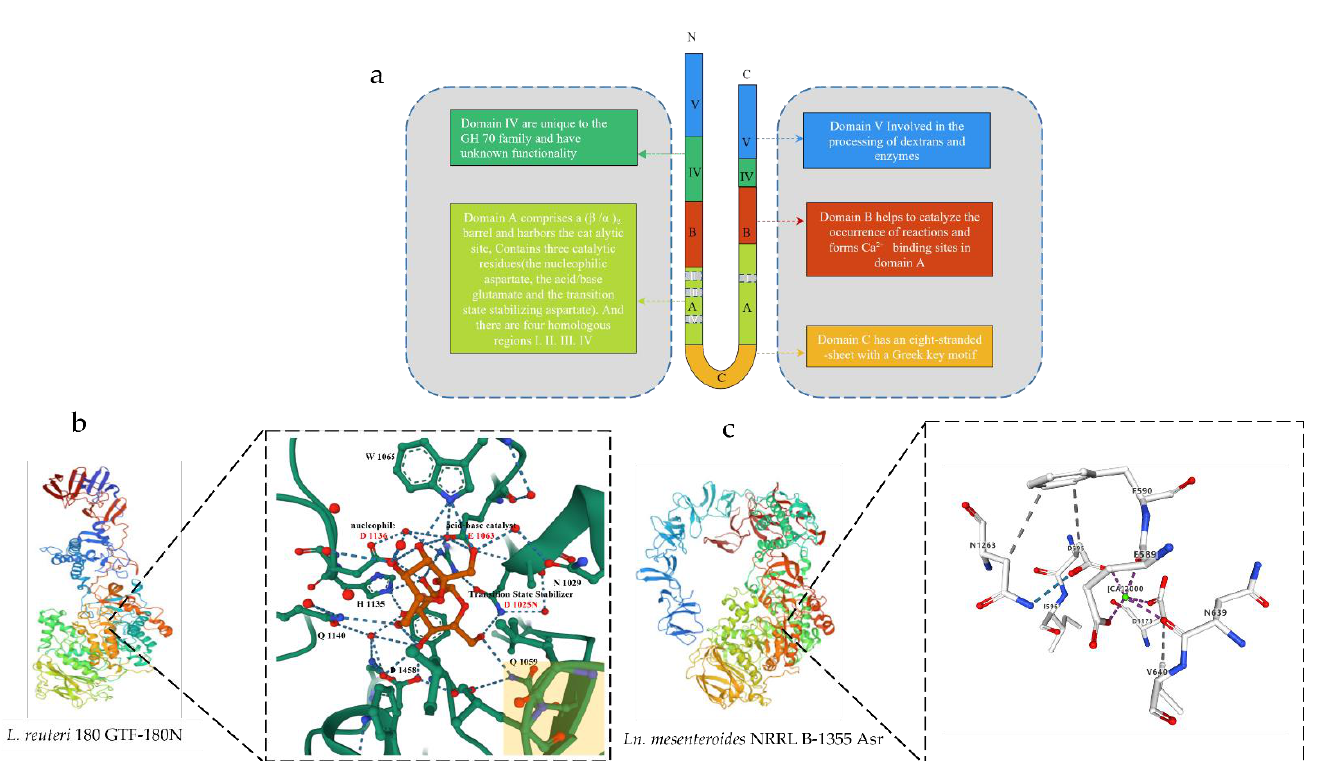
Figure 1. Schematic diagram of the 3D structure of GS. ( a ) Schematic representation of the U-shape fold formed by the various domains of GS. ( b ) Schematic diagram of the 3D structure of Ln. reuteri GTF-180N (PDB: 3HZ3) and sucrose binding site. Sucrose molecules are shown in red, residues in domain A are shown in green carbon, and residues in domain B are shown in yellow at the bottom right. ( c ) Schematic diagram of the 3D structure of Ln. mesenteroides NRRL B-1355 Asr (PDB: 6HVG) and Ca 2+ binding sites. The green circles represent Ca 2+ .